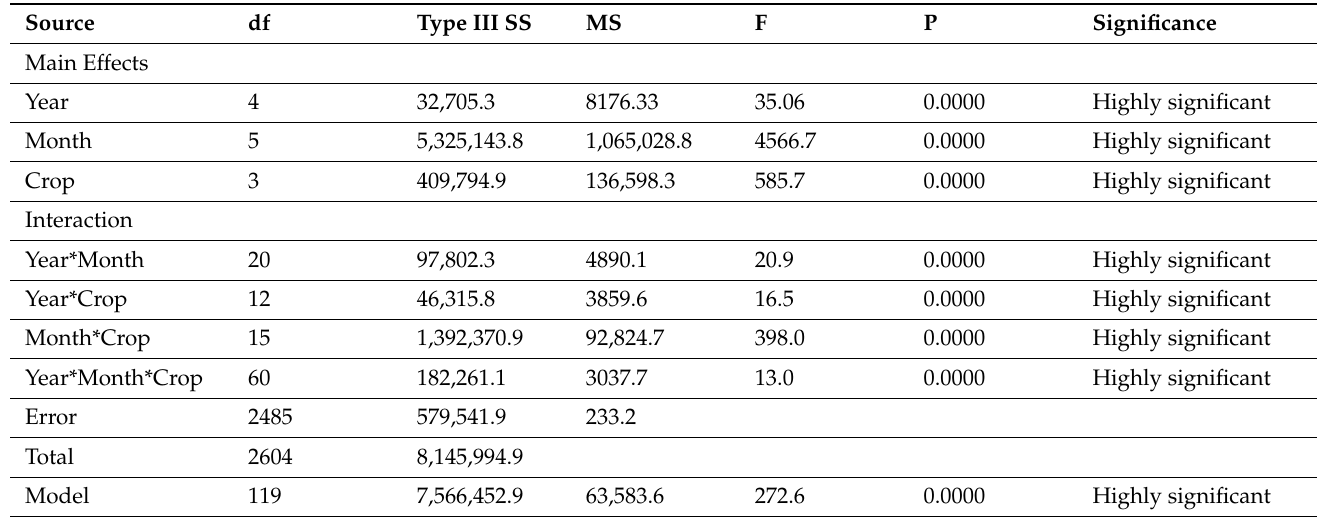
Table 1. Summary of the analysis of variance of crop monthly and seasonal ETa.